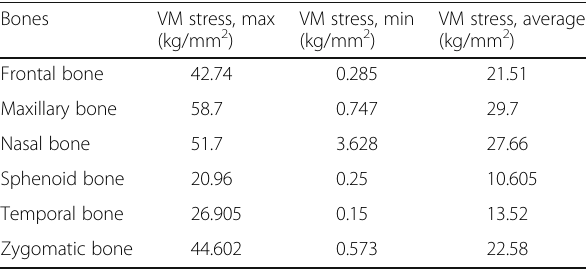
Table 2 Computational result of von Mises stress contours of the various skeletal